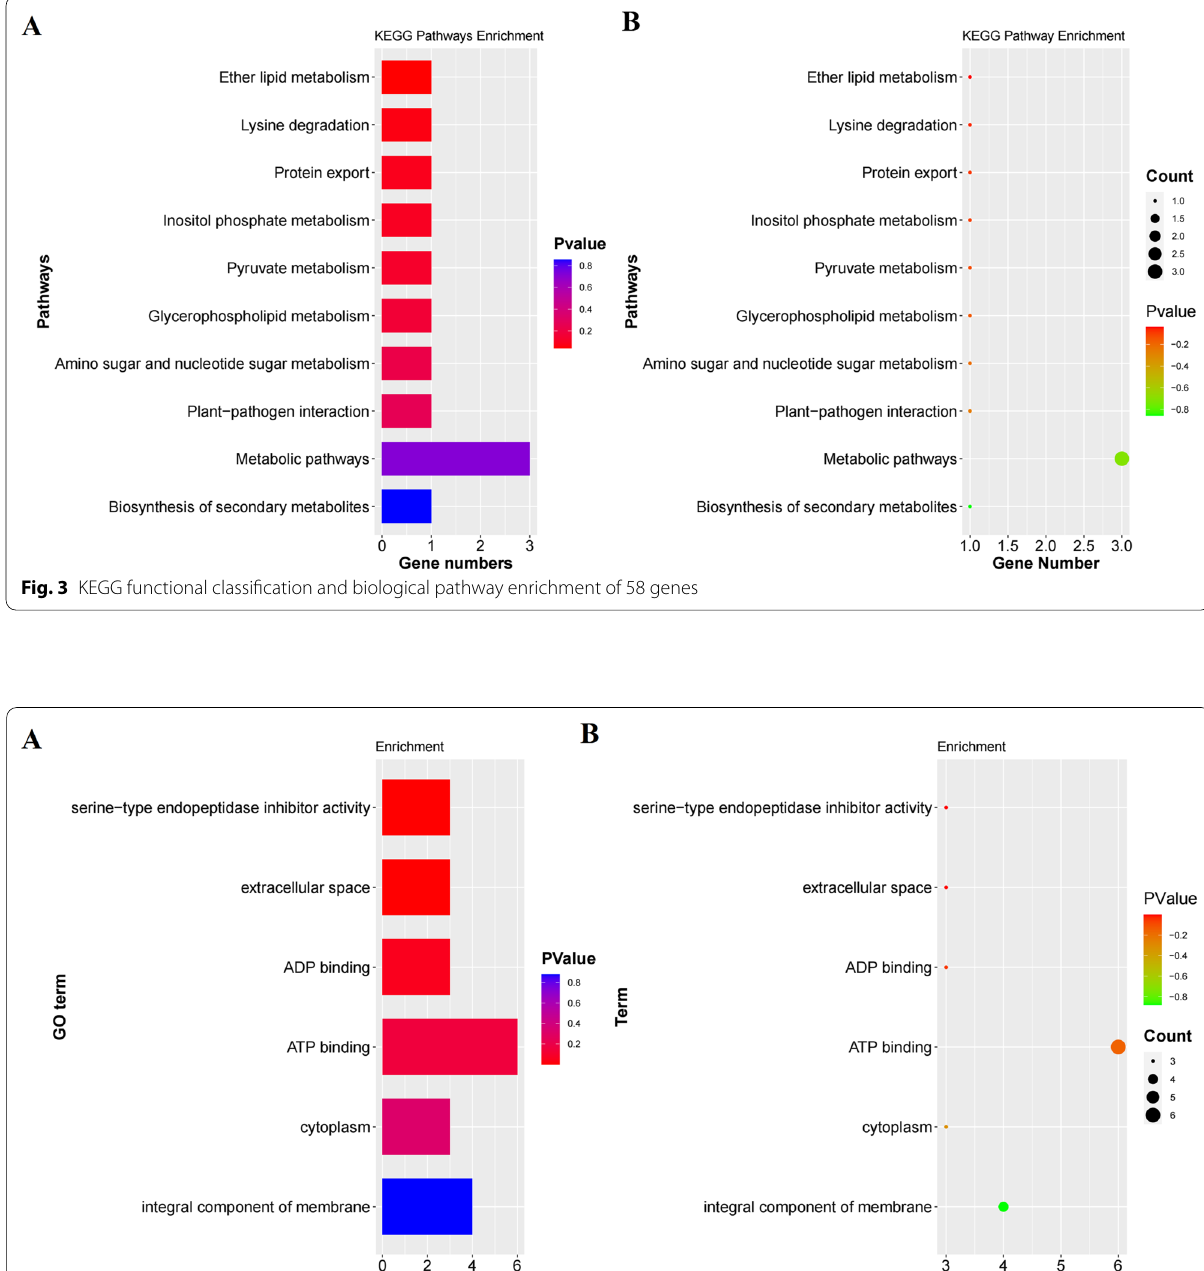
Fig. 4 GO classification analysis of 58